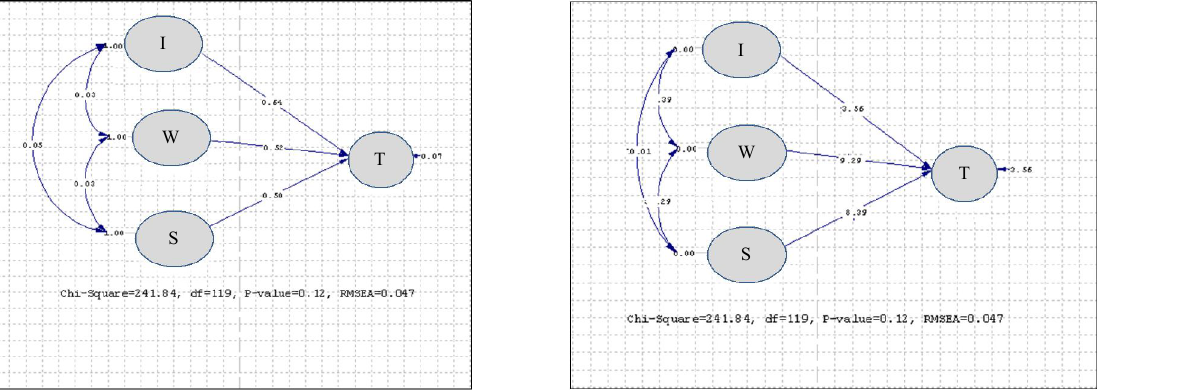
Fig. 1. The results of structural equation modeling